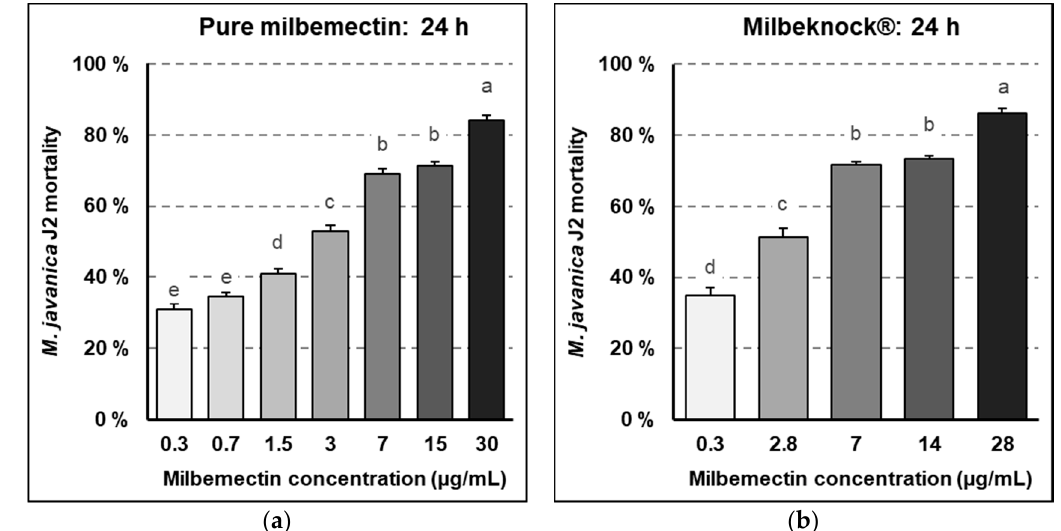
Figure 3. Mortality of Meloidogyne javanica second-stage juveniles due to progressively higher concentrations of pure milbemectin and Milbeknock ® . ( a ) After 24-h exposure to milbemectin; ( b ) after 24-h exposure to Milbeknock ® . Data are mean of eight replicates. Error bars indicate the standard error of the means. Bars with the same letter do not differ significantly by the HSD Tukey test ( p < 0.05).